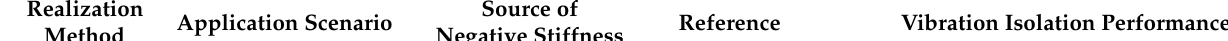
Table 1. QZS vibration isolators by different realization methods.